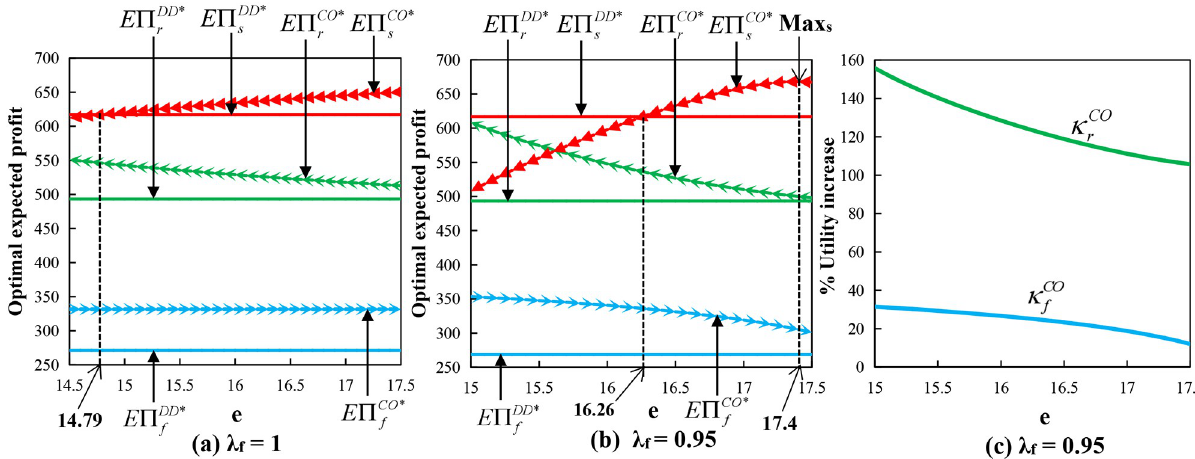
Fig 1. Impact of option exercise price under call option contract with wholesale price